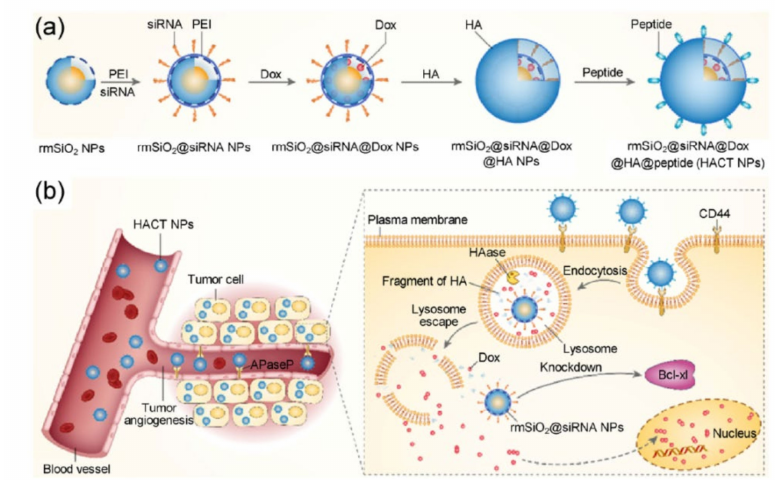
Figure 4. ( a ) Schematic representation of multilayered hyaluronic acid- polyethyleneimine (PEI)-rattle MSNs, with a cascade of two targeting agents (hyaluronic acid, HA, and peptide) and two cancer therapeuticagents(connectivetissuegrowthfactor(CTGF)siRNAandDox). ( b )Schematicrepresentation of the therapeutic mechanism of CTGF siRNA and Dox co-loaded multilayered hyaluronic acid-PEI-rattle MSNs for the treatment of CTGF overexpressing breast cancer. This image is used without modifications from [99]. Copyright © 2017,